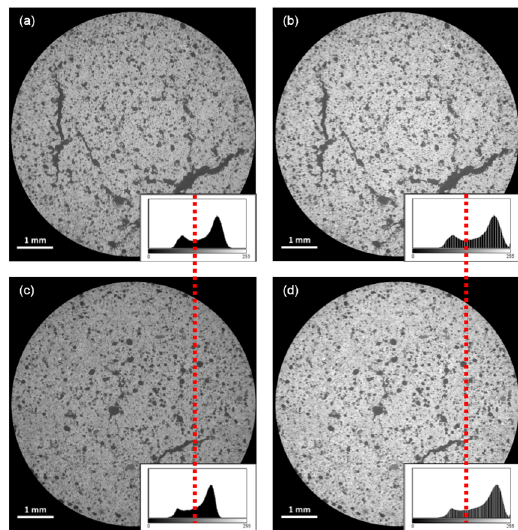
Figure 8. Effect of contrast expansion: (a, c) before contrast expansion histogram minima do not match; (b, d) after expansion the minima match.